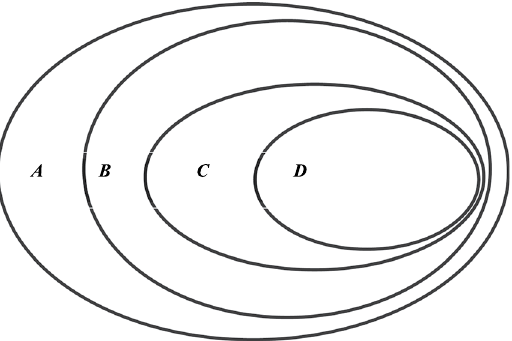
Figure 6. A is the space of rooted phylogenetic networks; B is the space of k th-order reduced phylogenetic networks ( k ≥ 2); C is the space of partly reduced phylogenetic networks; and D is the space of reduced phylogenetic networks.